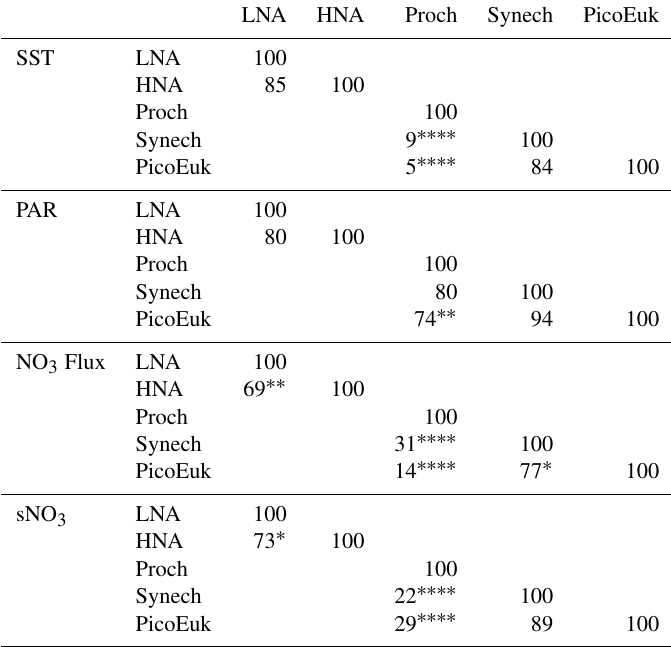
Table 4. Partial weighted niche overlap (%) for each environmental factor and picoplankton subgroup. sNO 3 represents surface nitrate concentration. Asterisks denote the existence of significant differences among niches ( ∗ p < 0 . 1, ∗∗ p < 0 . 05, ∗∗∗ p < 0 . 01, ∗∗∗∗ p < 0 . 001). LNA HNA Proch Synech PicoEuk SST